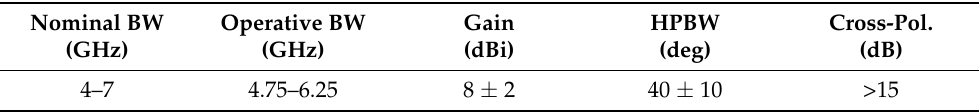
Table 1. Performance summary of the circularly polarized antenna element composing the SBA; experimental